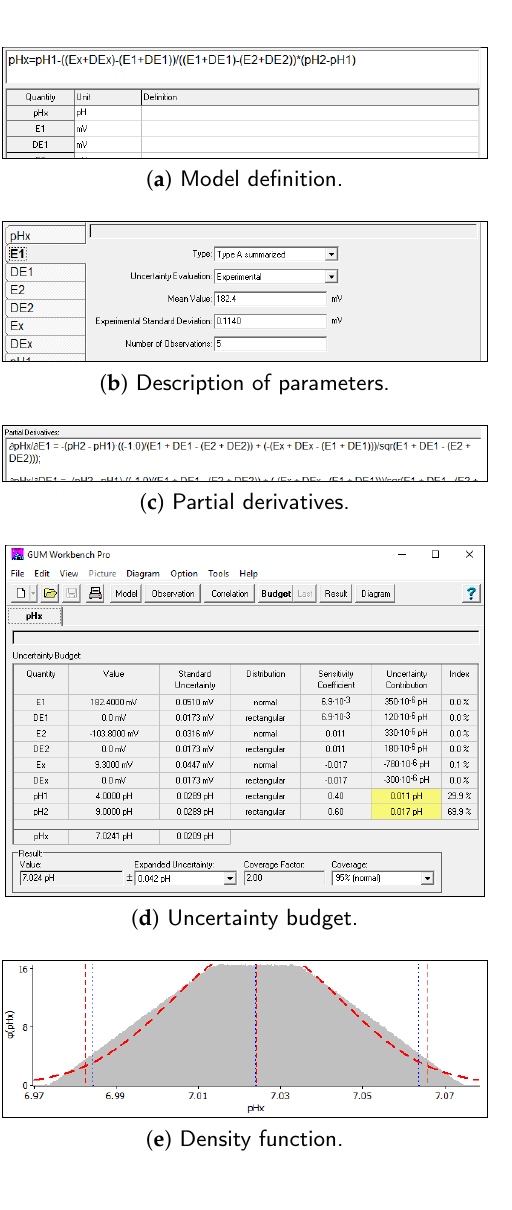
Figure 6. Screens of Metrodata GUM Workbench Professional Version 2.4 ( left ) and Qualisyst GUM Enterprise 4.10 ( right